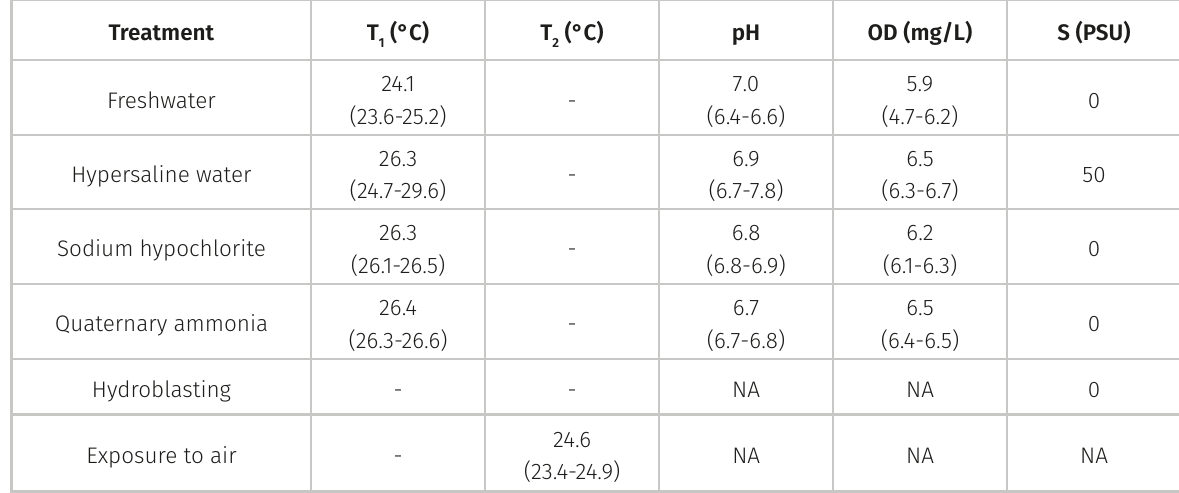
Table III. Abiotic variables measured during the oyster cleaning phase. The observed differences between the treatments were not significant (p>0.05). T salinity; NA: Not